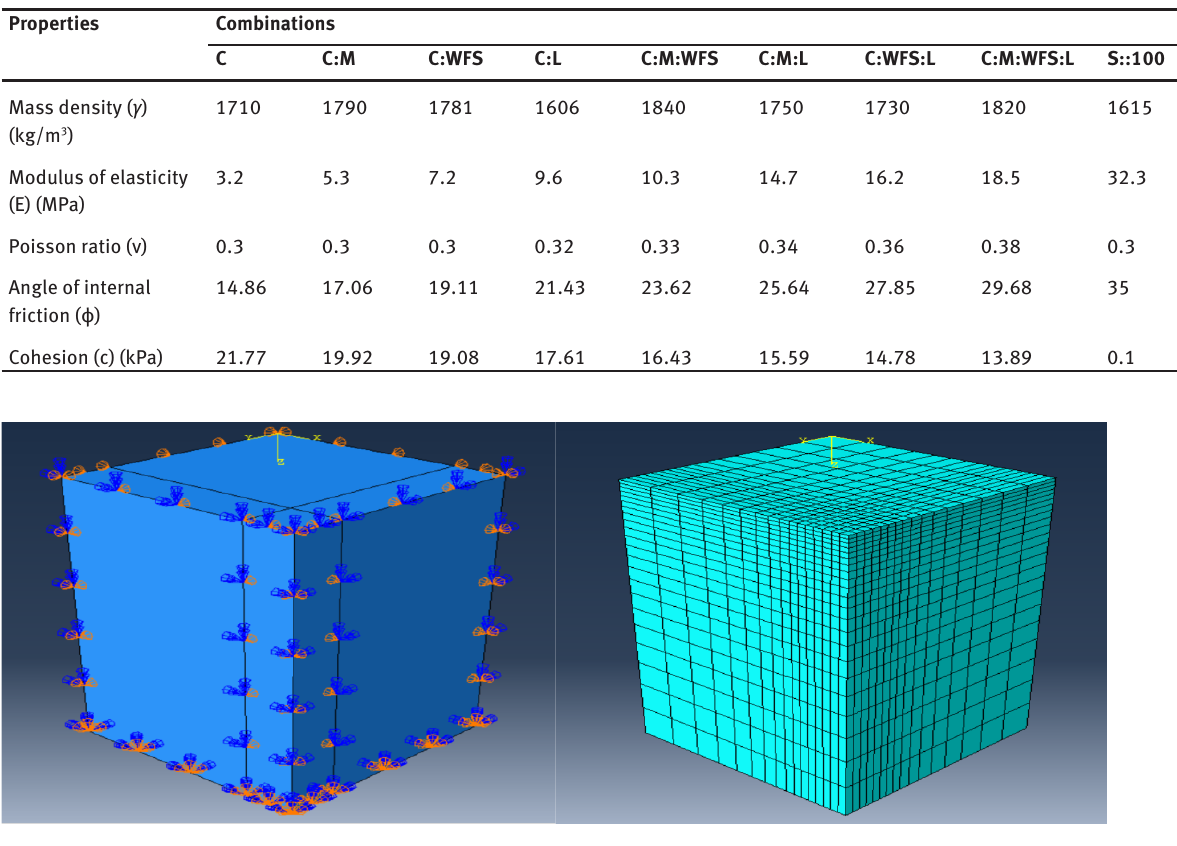
Figure 3: Finite element discretization and boundary condition selection of the footing model with L/B=1.